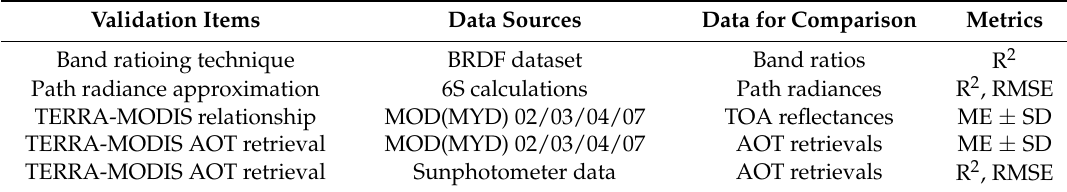
Table 2. Summary of the validations in this study. R 2 is coefficient of determination, RMSE is root mean square error, ME is mean error, and SD is standard